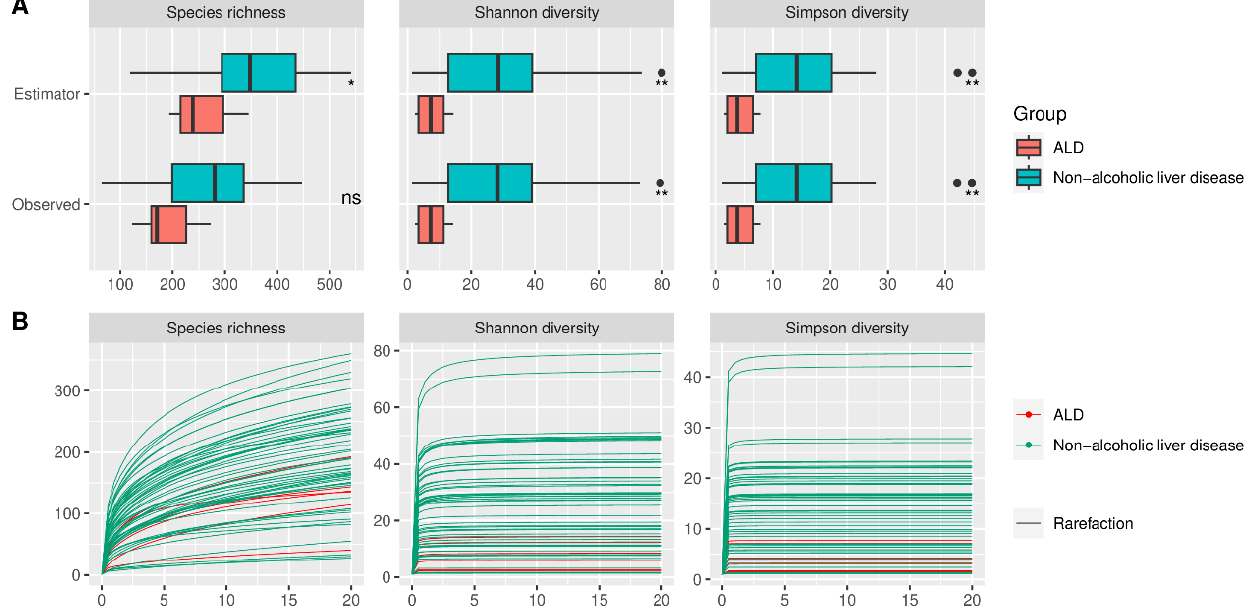
Figure 4. ( A ) Observed and estimated alpha diversity for comparison between patients with alcoholic liver disease and patients with other, non-alcoholic etiologies of liver disease. Black dots denote outliers. ( B ) Rarefication–extrapolation curves for alpha-diversity measures. Each curve represents the alpha diversity of a single sample rarefied to a common read depth of 20,000; ALD—alcoholic liver disease, *— p < = 0.05, **— p < = 0.01, ns — non-significant. In three out of five data sets (DRP003174, SRP187981, and SRP300989), beta diversity was significantly different for the comparison of HC versus AUD (Figure 5). Beta-diver- sity differed significantly also for the ALD vs. nonalcoholic liver disease and AUD vs ALD comparison (both examined by one dataset each, SRP185798 and SRP187981, respec- tively).